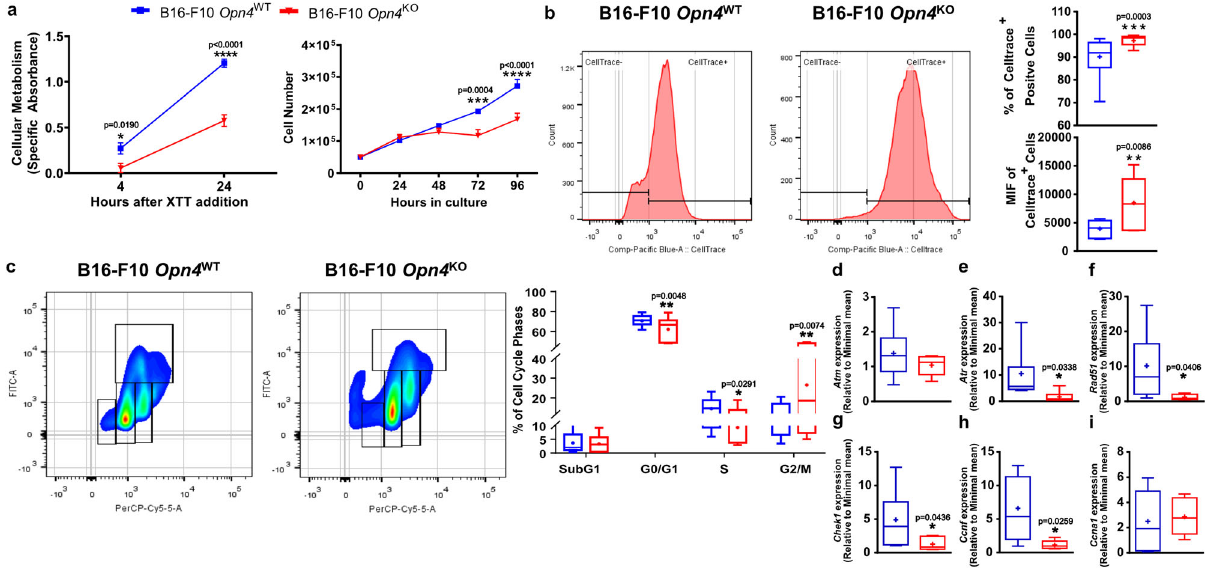
Fig. 2 In vitro growth of Opn4 KO malignant melanocytes is reduced and is associated with delayed cell cycle progression. a Metabolic evaluation using daily XTT assay for 4 and 24 h ( n = 12 for each group) and proliferation assay by cell counting for 96 h ( n = 6 for each group). b Proliferation assay by Celltrace ™ staining using fl ow cytometry. Celltrace ™ positive cells are represented. In a and b , error bars are shown as SEM. Quantitative analysis of Celltrace ™ positive cells and median intensity fl uorescence (MIF) of Opn4 WT and Opn4 KO malignant melanocytes ( n = 15 for each group). c Evaluation of cell cycle populations and expression of cell cycle-related genes in Opn4 WT and Opn4 KO malignant melanocytes. Negative control is shown in Fig. S2. Arrows show the respective cell cycle phase. Boxplots show the quantitative evaluation of cell cycle phases by fl ow cytometry ( n = 18 and 15 for Opn4 WT and Opn4 KO cells, respectively). d – i Expression of cell cycle-related genes in Opn4 WT and Opn4 KO malignant melanocytes. In d , e , n = 11 and 6 for Opn4 WT and Opn4 KO , respectively; in f , n = 11 and 5, respectively; in g , n = 11 and 6, respectively; in h , n = 9 and 5, respectively; in ( i ), n = 10 and 6, respectively. In every analyzes, the n number is derived from independent